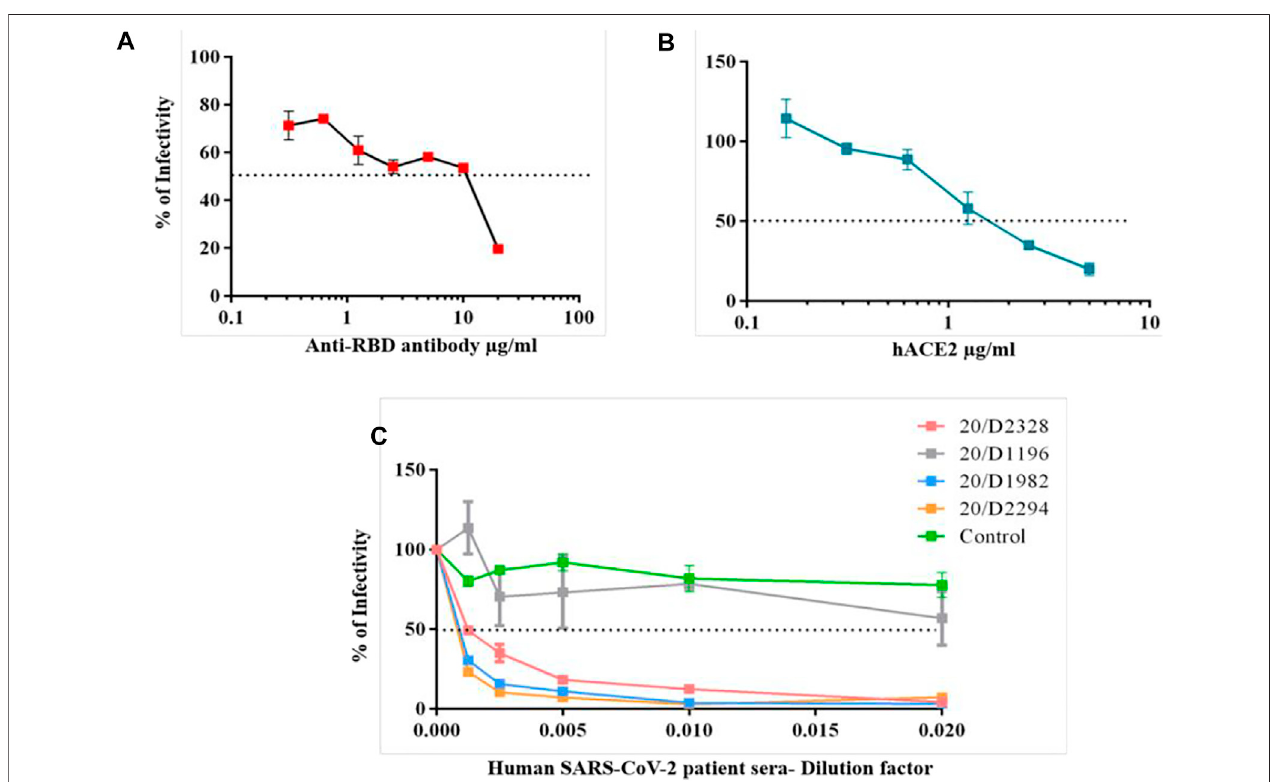
FIGURE4| SpikeG614pseudovirusneutralizationassay.ThespikeG614pseudoviruswasneutralizedwiththeanti-RBDantibody (A) ,solublehACE2protein (B) , and human SARS-CoV-2 patient sera (C) at different dilutions. After 1 h of incubation, spike G614 pseudovirus was infected into 293T-hACE2 cells for 72 h. Later, the percentage of infectivity was calculated by the luciferase